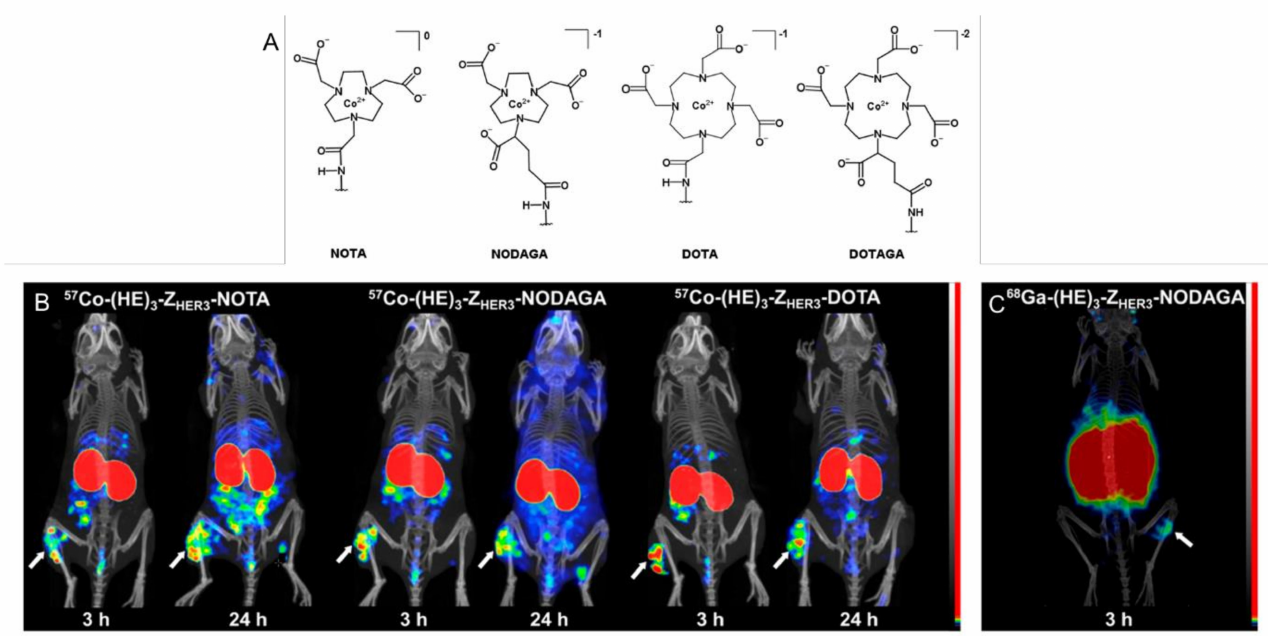
Figure 21. Chemical structures and charges of studied cobalt-chelate complexes ( A ). SPECT/CT images of the [ 57 Co]Co- HEHEHE-Z HER3 -X affibody with NOTA, NODAGA, or DOTA chelator ( B ). For each agent tested, the later imaging timepoint produced better tumor contrast. PET/CT of [ 68 Ga]Ga-HEHEHE-Z HER3 -NODATA was only possible to 3 h PI and showed greater kidney accumulation ( C )